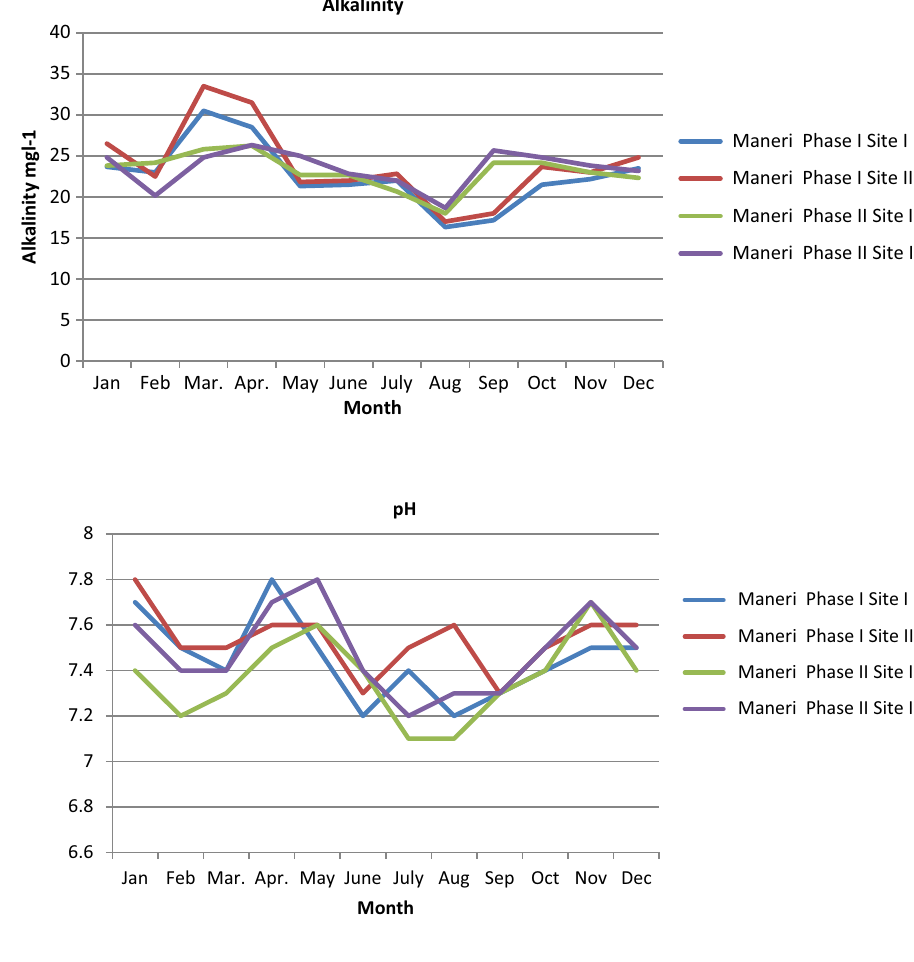
Fig. 7 Monthly recorded pH